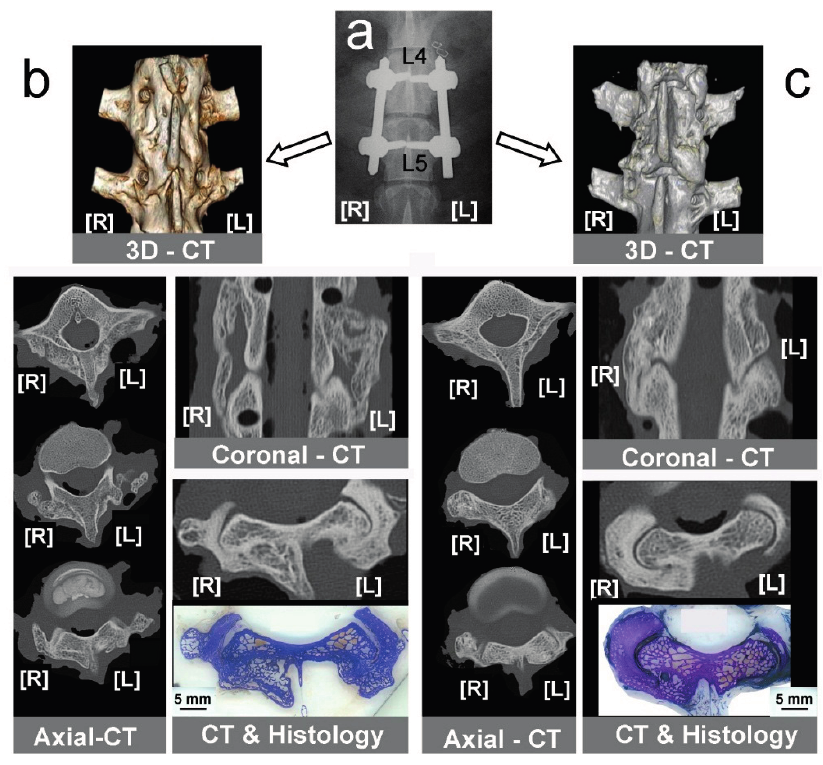
Figure 3. Computed tomography (CT) diagnosis of instrumented lumbar fusion. ( a ) Control X-ray radiography taken after surgery, showing screws and rods used to fix L4–L5 vertebral bodies. [L], left side; [R], right side; ( b ) CT-study in bone graft groups showing 3D-CT reconstruction, axial-CT, a coronal-CT showing bone formation in both sides, and correlated axial-CT & histological section. [L] left side, Allo-group; [R] right side, Auto-group; ( c ) CT-study in mineral scaffold groups showing 3D-CT reconstruction, some axial-CT, a coronal-CT, and correlated axial-CT and histological section, assessing fusion only in right side. [L] left side, HA group; [R] right side, HA + MSCs